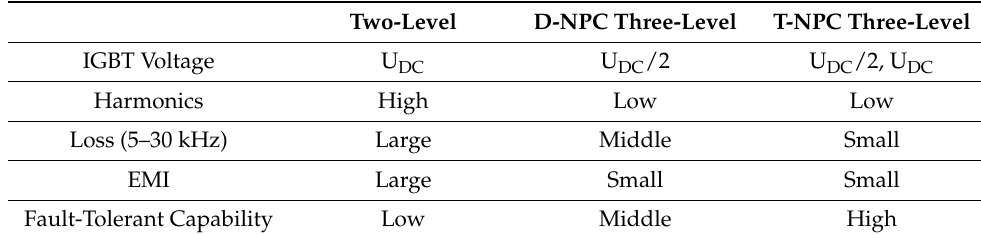
Table 2. Performance comparison